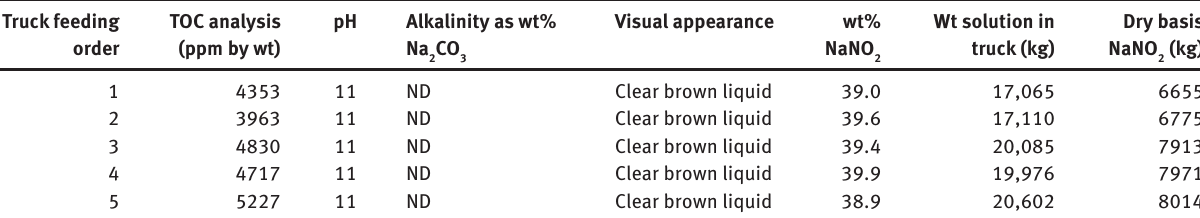
to be carbon-treated. 2